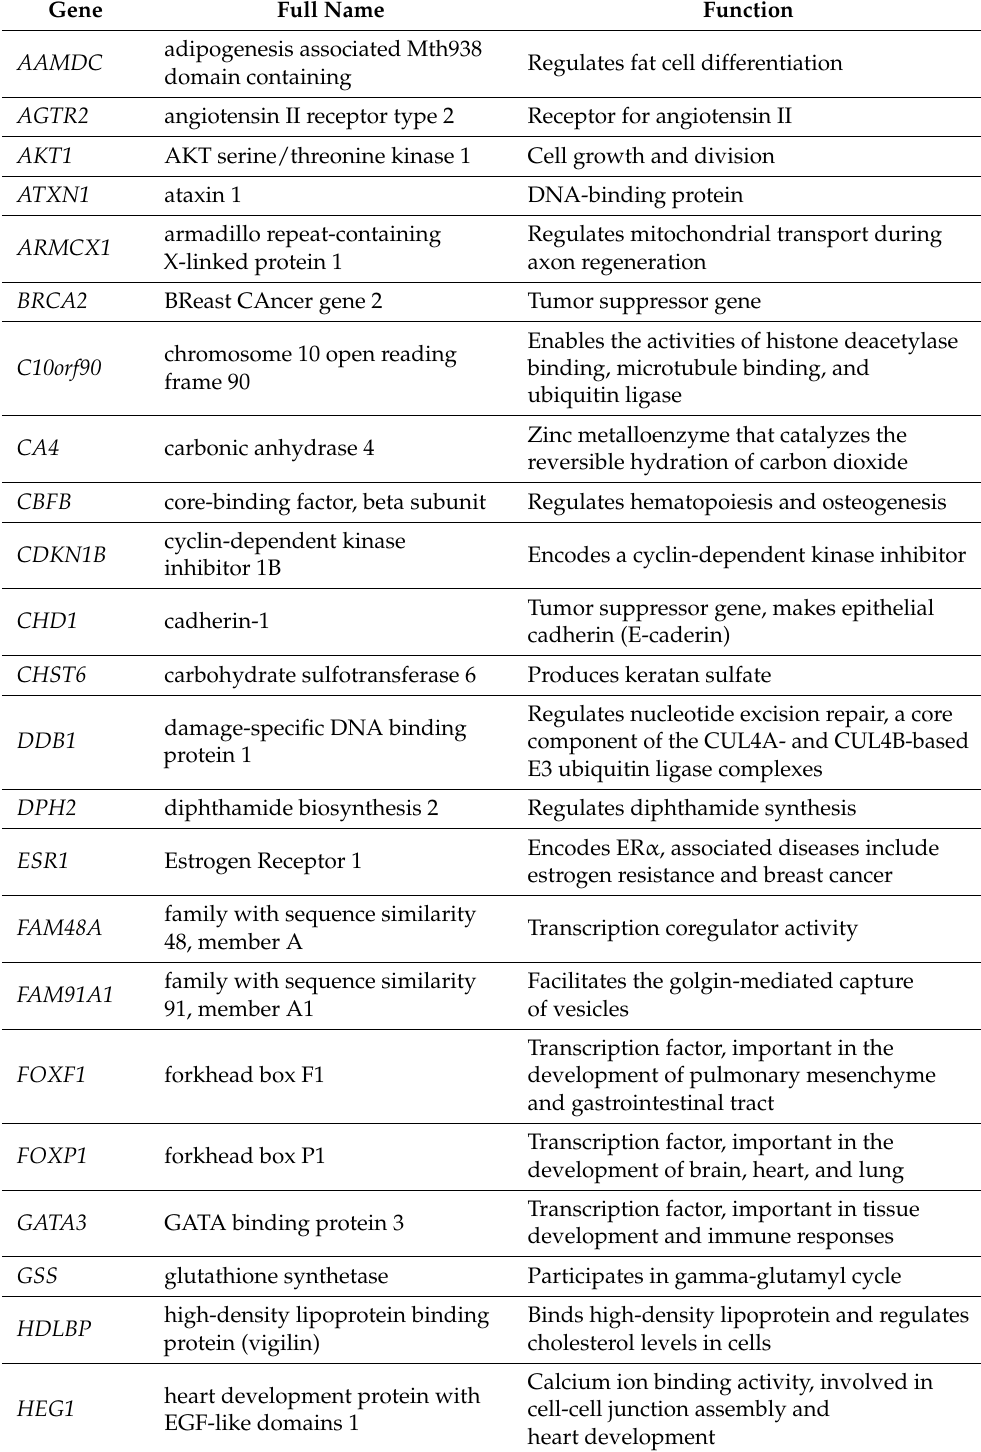
Table 2. Commonly mutated genes in HR-positive breast cancer (alphabetical